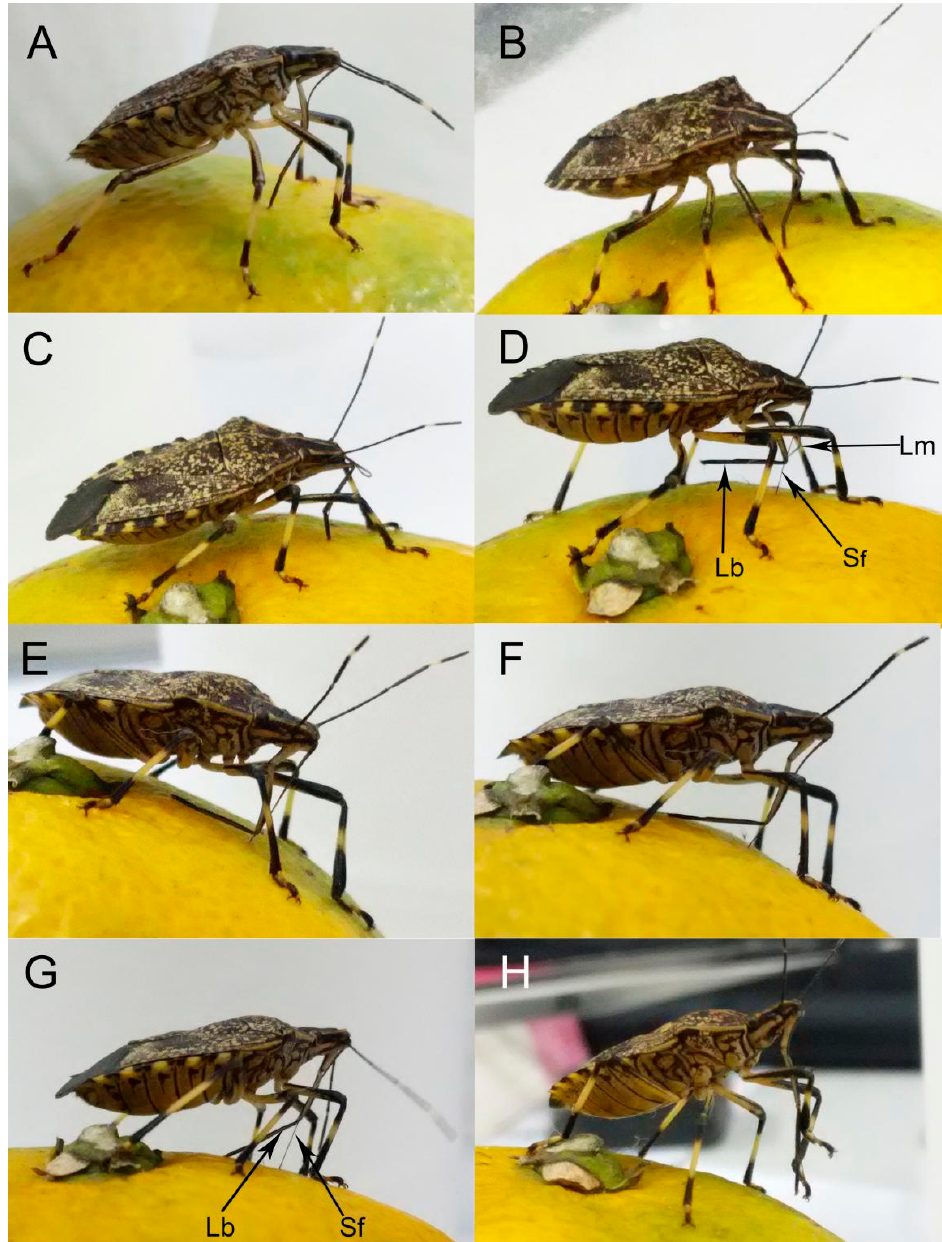
Figure 12. Feeding stages on orange in adult E. fullo showing positions of the mouthparts. ( A ) Location of suitable feeding position by the labium; ( B ), ( C ) Puncture of orange by stylet fascicle showing elbow-like fold of proximal and second rostral segments and stylet penetration; ( D ) The bug lifts up the third and fourth segments of labium parallel to host surface and then feeds; ( E ) The bug gradual straightens the first and second labial segments; ( F ), ( G ) Termination of feeding showing retraction of stylets; ( H ) Use of forelegs to return stylet fascicle to labial groove; Lm, labrum; Lb, labium; Sf, stylet fascicle.